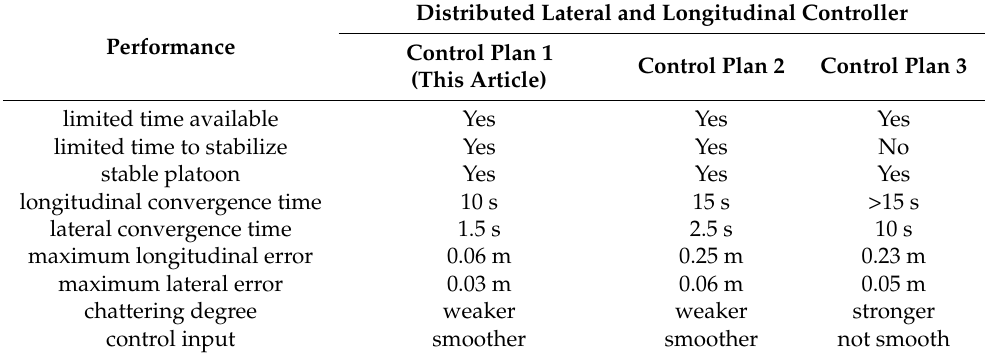
Table 3. Lateral and longitudinal control performance of bus